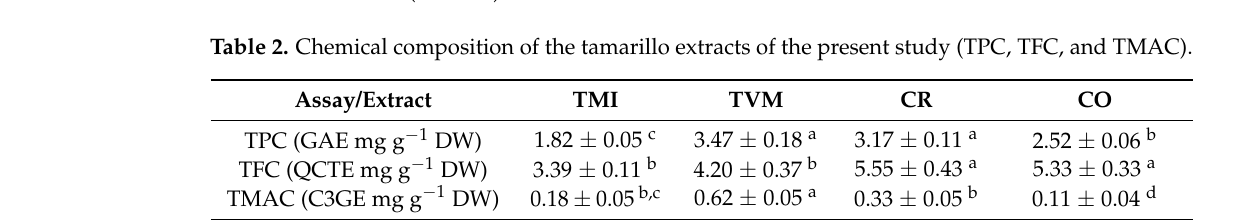
ences (Tukey’s post hoc test, p ≤ 0.05).